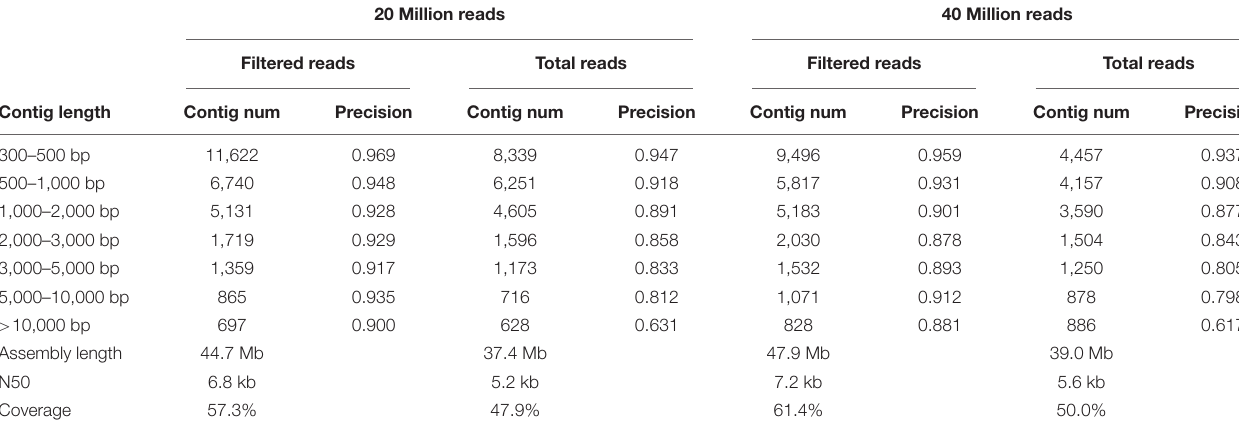
TABLE 2 | Comparison of assembly precision, using filtered reads and total reads. 20 Million reads 40 Million